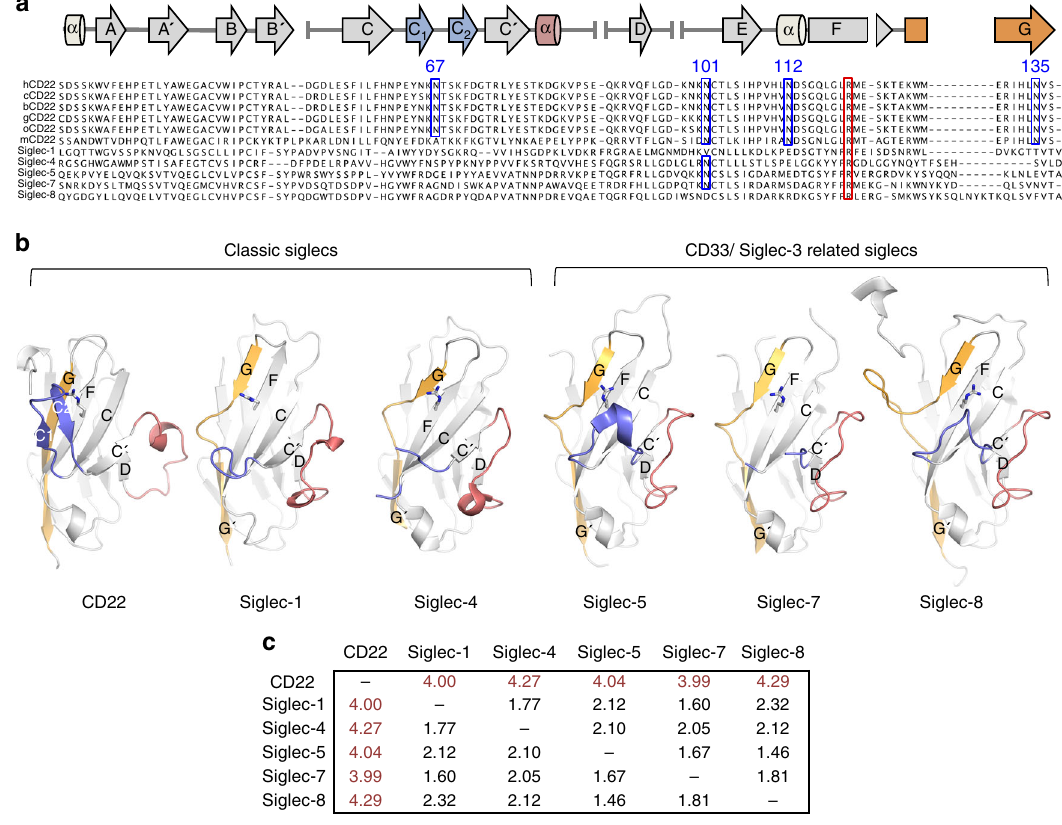
Fig. 2 Differences in ligand binding domain d1 among the Siglec family. a Sequence alignment of the V-type domain of mammalian CD22 and other Siglecs. Siglec -1, -4, -5, -7, and -8. hCD22 secondary structure elements are represented atop the alignment. Putative N-glycosylation sites N67, N101, N112, and N135 are highlighted in blue boxes . Conserved R120 involved in binding Sia ligands is marked by a red box . b Comparison of available three-dimensional structures of V-type domains from classic Siglecs (including the CD22 structure reported here, Siglec-1 (PDB ID: 1QFP) 67 and Siglec-4 (PDB ID: 5LFR) 23 ) and CD33/Siglec-3-related Siglecs (Siglec-5 (PDB ID: 2ZG2) 24 , Siglec-7 (PDB ID: 1O7S) 26 , and Siglec-8 (PDB ID: 2N7A) 51 ). Differences in C – C ′ ( blue ), C ′ – D ( red ), and strand G ( orange ) conformations are highlighted. R120 is shown as sticks . c Uniqueness of the CD22 V-type fold compared to other Siglecs is evident from elevated C α r.m.s.d. values calculated with MOE 60 . hCD22 human CD22, cCD22 CD22 from Pan troglodites (chimpanzee), bCD22 CD22 from Pan paniscus (bonobo), gCD22 CD22 from Gorilla gorilla (gorilla), oCD22 CD22 from Pongo pygmaeous (orangutan), mCD22 CD22 from Mus